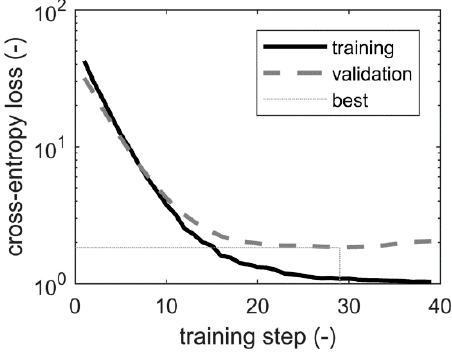
Figure 14. Learning curves of the convolutional neural network.